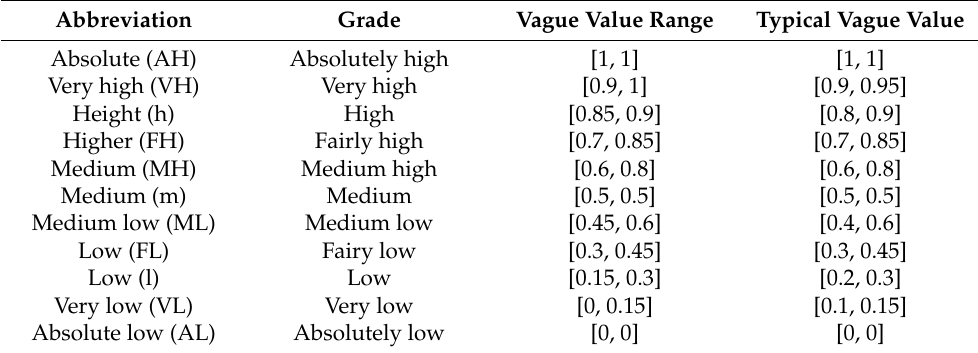
Table 1. Vague set language variables representing